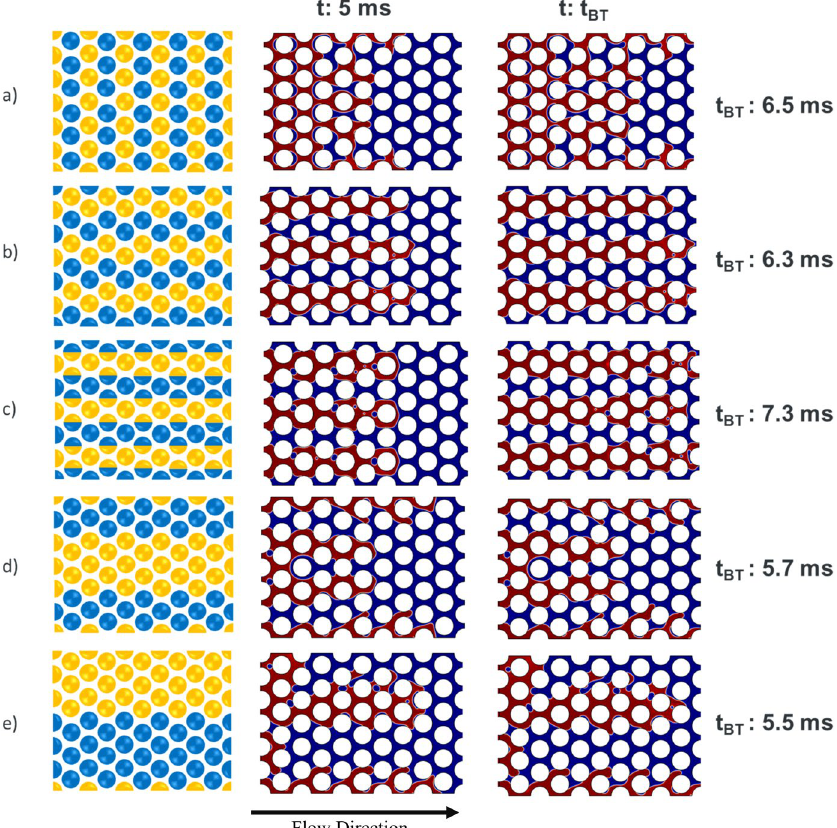
Figure 7. The dynamics of air (red) displacing water (dark blue) at log Ca = − 4 and log M = − 2 for five porous media with different wettability heterogeneity